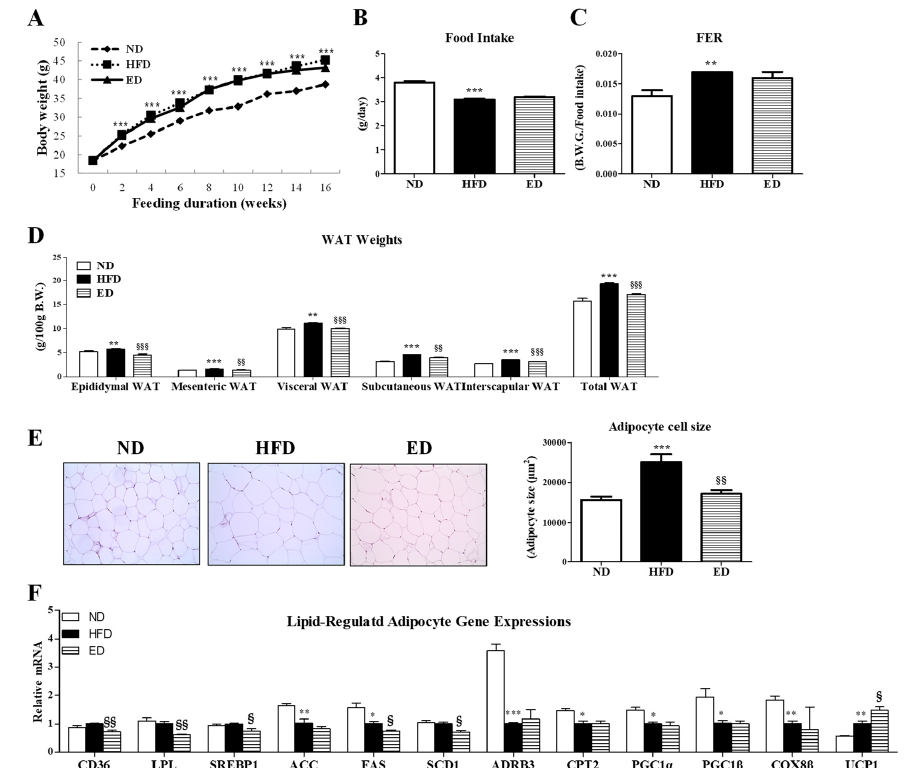
Figure 1. Effect of eriodictyol treatment on body weight (BW) ( A ), food intake ( B ), food efficiency ratio ( C ), white adipose tissue (WAT) weights ( D ), WAT morphology (200 × magnification) and adipocyte cell size ( E ), and expression of adipocyte genes ( F ) in C57BL/6N mice fed with the high-fat diet (HFD). Data are presented as means ± SEM. Normal diet (ND; AIN-76) vs. HFD; * p < 0.05, ** p < 0.01, *** p < 0.001. HFD vs. ED (HFD + 0.005% ED); § p < 0.05, §§ p < 0.01, §§§ p < 0.001.